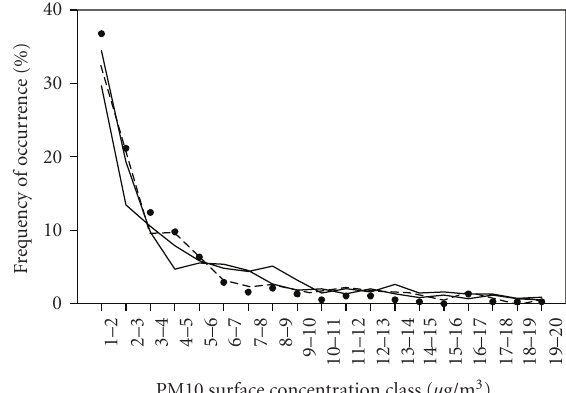
Figure 1: Frequency distribution of modelled PM10 surface concentrations. Finokalia: solid line; Thrakomakedones: bold solid line; Volos: dashed line; Panorama: